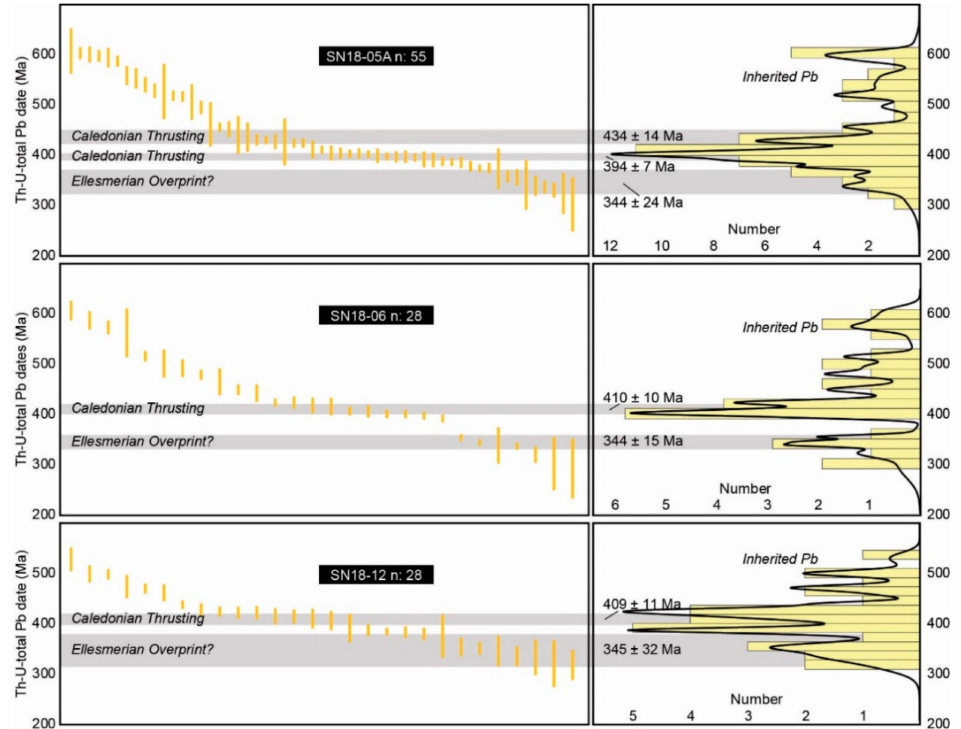
Figure 7. Results of monazite Th-U-total Pb geochronology of samples SN18-05A ( top ), SN18-06 ( middle ) and SN18-12 ( bottom ). The left diagrams show the individual dates ( ± 2 σ uncertainty) organized from oldest to youngest. The right side depicts histograms of the samples with corresponding relative frequency curves. The populations were derived by Gaussian deconvolution of each entire sample dataset. The grey bars represent the uncertainty of each population that has been attributed geological significance. Interpretations of each population are presented within the grey